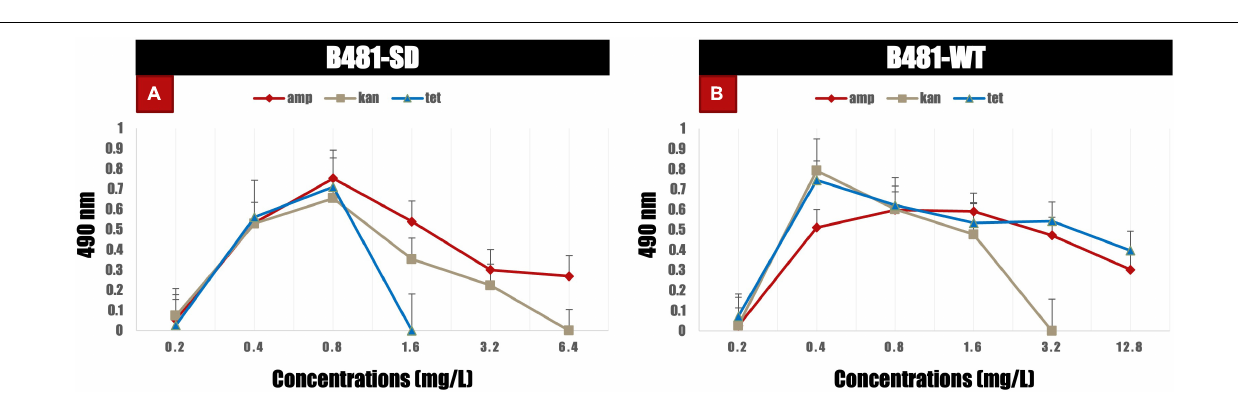
FIGURE 5 | Lactate dehydrogenase activity in B481-SD and B481-WT strains of Fremyella diplosiphon exposed to varying concentrations of ampicillin, kanamycin, and tetracycline (A,B) on day 6. Mean and standard deviations are indicated by error